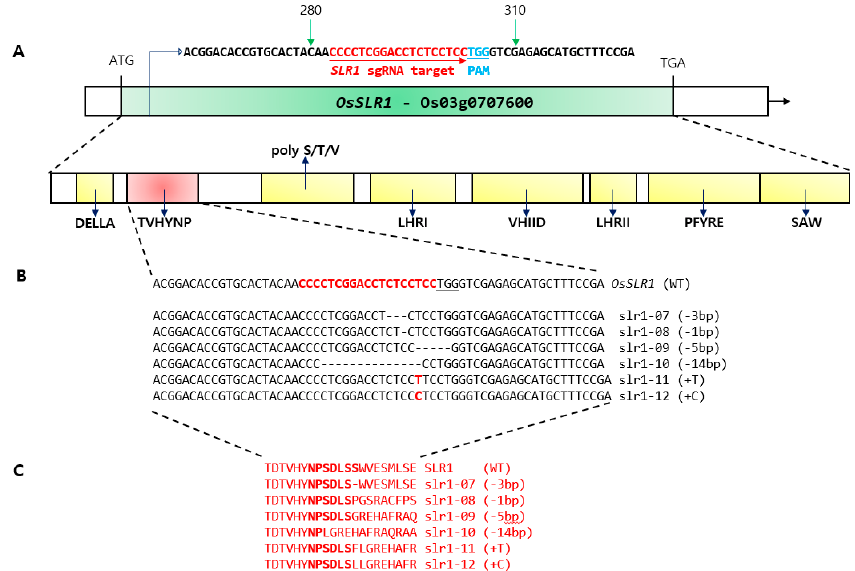
Figure 1. Genome editing in the rice OsSLR1 gene. ( A ) Design of single guide RNA (sgRNA) sites in the TVHYNP motif; the nuclease cleavage site is represented by the red arrow and the Protospacer Adjacent Motif (PAM) (NGG) appears in blue. DELLA protein organization representing the conserved domains. ( B ) Nucleotide sequence alignment by deep sequence analysis of the sgRNA target region in six mutant lines of transformed rice plants. Deletion and insertion indicated by dash and red letters, respectively. ( C ) Amino acid sequences of the target region in six mutant lines.